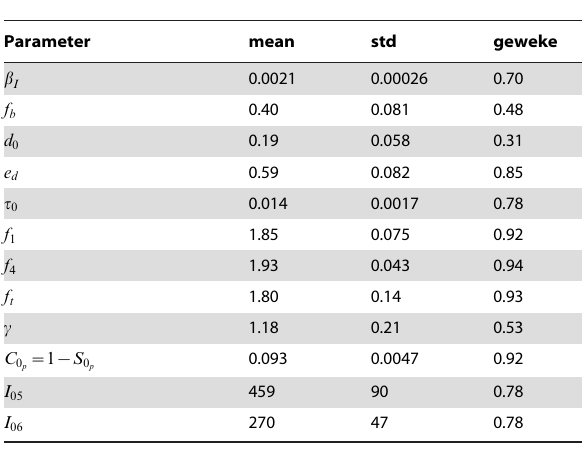
Table 2. Statistics for estimated parameters based on the Markov chain generated by the adaptive Metropolis Hastings algorithm with 2004–2006